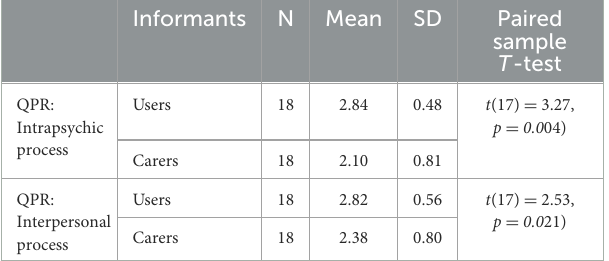
TABLE 2 The mean scores and standard deviation of QPR sub-scales for users and carers in the matched sub-group ( n =